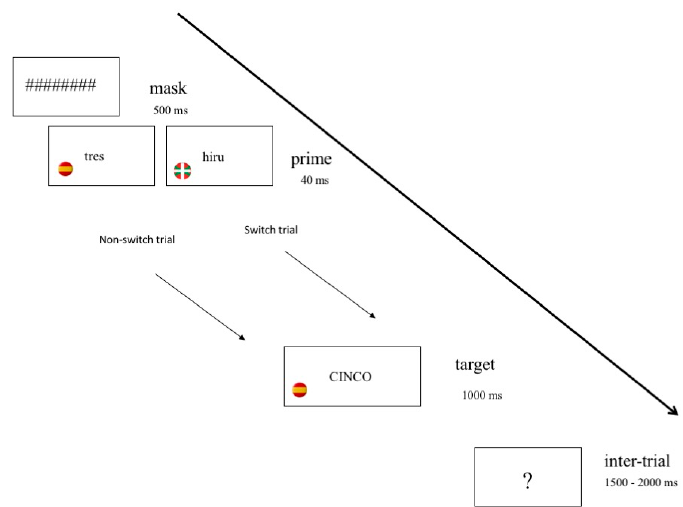
Figure 2. The design of this experiment was masked priming. Non-switch trials: The target was in the same language as the prime (e.g., tres–CINCO). Switch trials were Spanish-Spanish or Basque-Basque. Switch trials: The target was in a different language (e.g., hiru–CINCO). Non-switch trials were Spanish-Basque switches and Basque-Spanish switches.